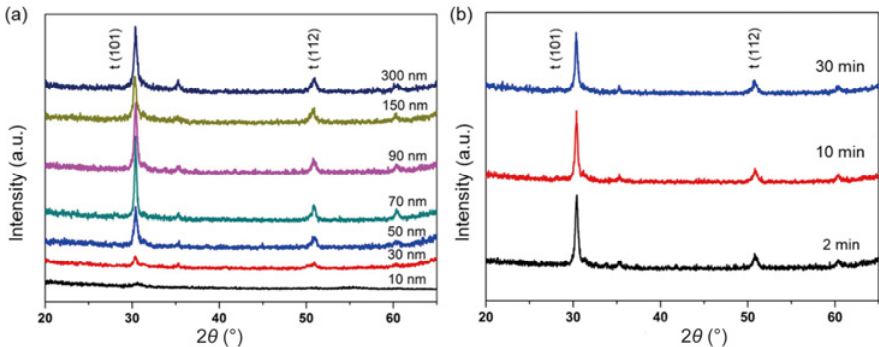
Fig. 3 (a) Ex-situ XRD patterns of ZrO 2 films with different thicknesses after RTA at corresponding T C . (b) XRD results of 90-nm-thick ZrO 2 film annealed at its T C for different